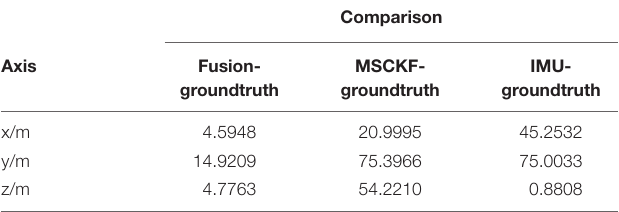
TABLE 2 | Mean square deviation of errors in x, y, and z directions.